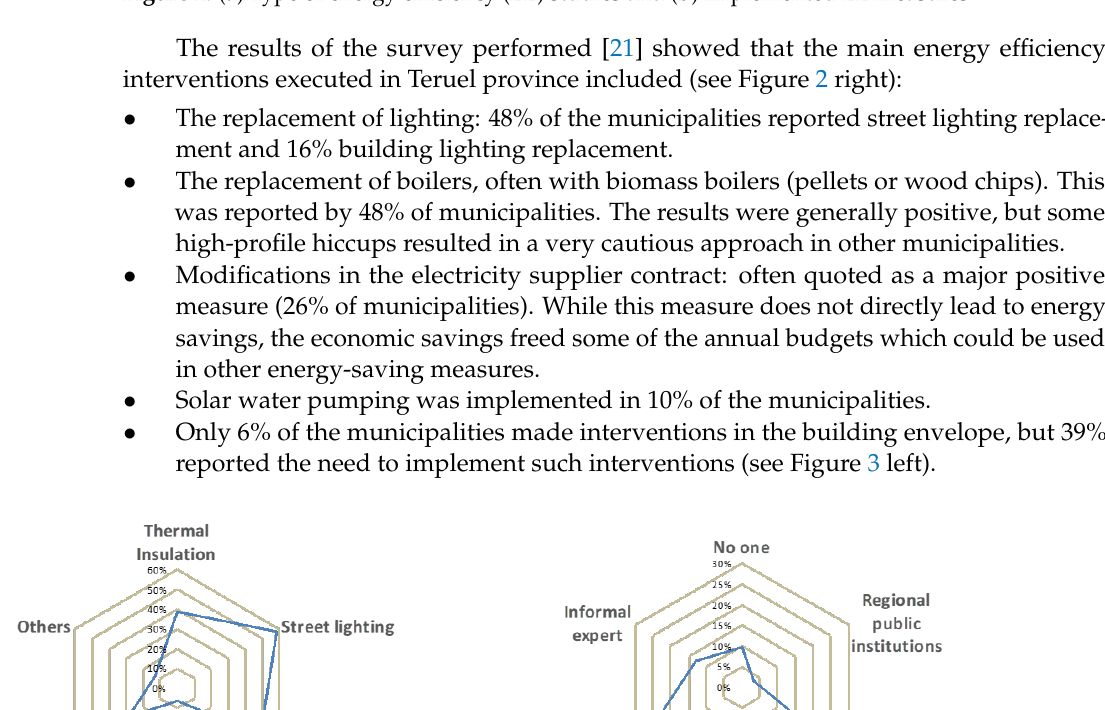
Figure 2. ( a ) Type of energy efficiency (EE) studies and ( b ) implemented EE measures.